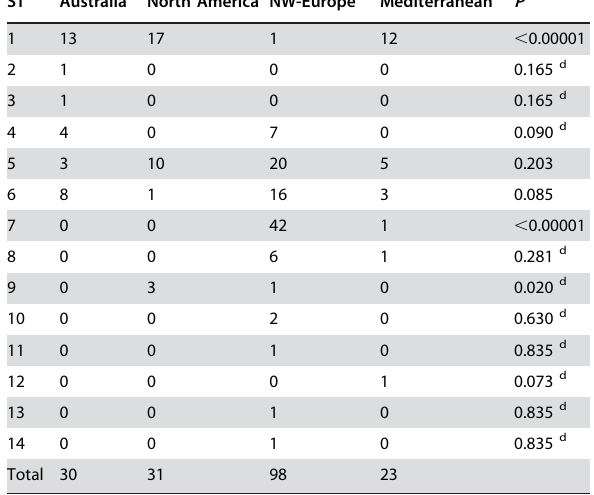
Table 2. Correlation between ST and geographic